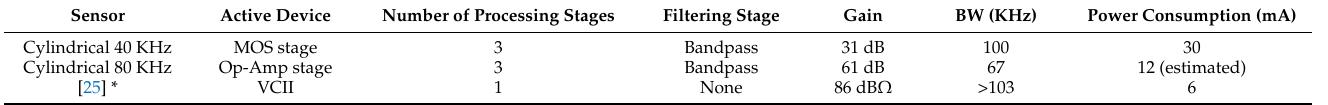
Table 4. Comparison between a VCII-based PVDF sensor read-out circuit and conventional ones.